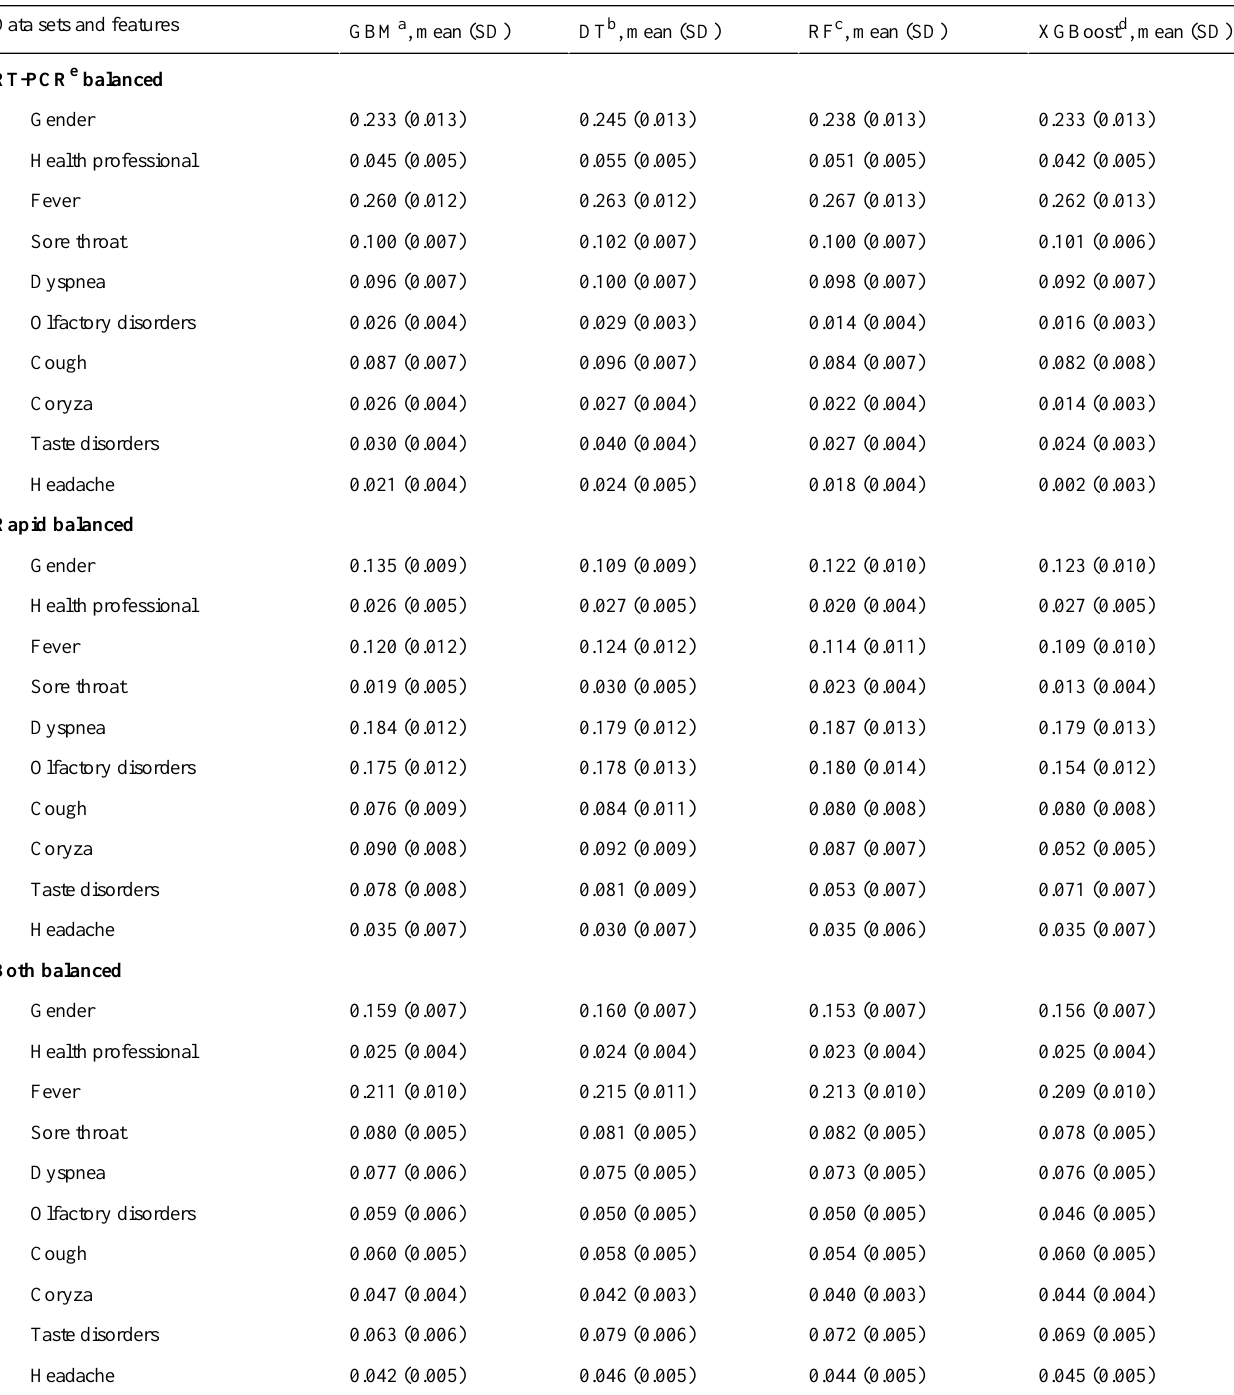
Table 3. The average importance and SD values for each feature for the decision tree–based classification models using the balanced data